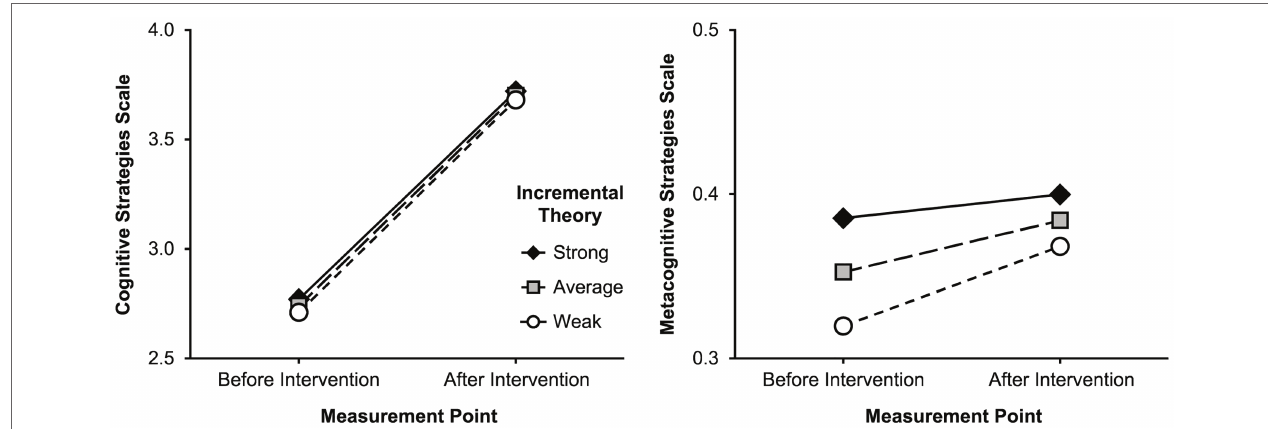
FIGURE 1 | Predicted values for self-report scales of learning strategy use. The measures were predicted before and after the learning strategy intervention for different strengths of incremental theory (strong = one SD above the mean, weak = one SD below the mean). Values are based on the models from Table 4 that control for reading comprehension.